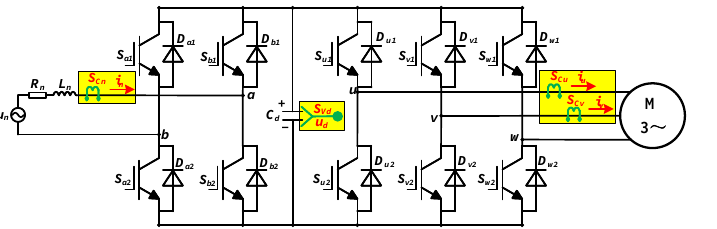
Figure 1. The topology of the two-level converter.